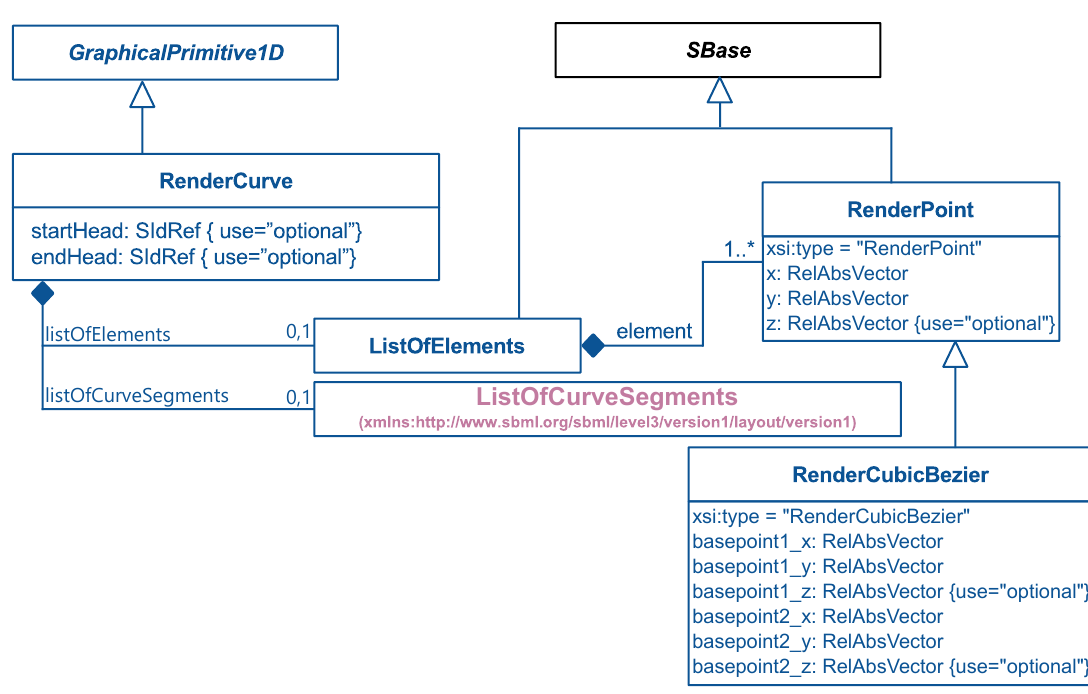
Figure 11: A UML representation of the RenderCurve classes for the Render package. See Section 1.4 for conventions related to this